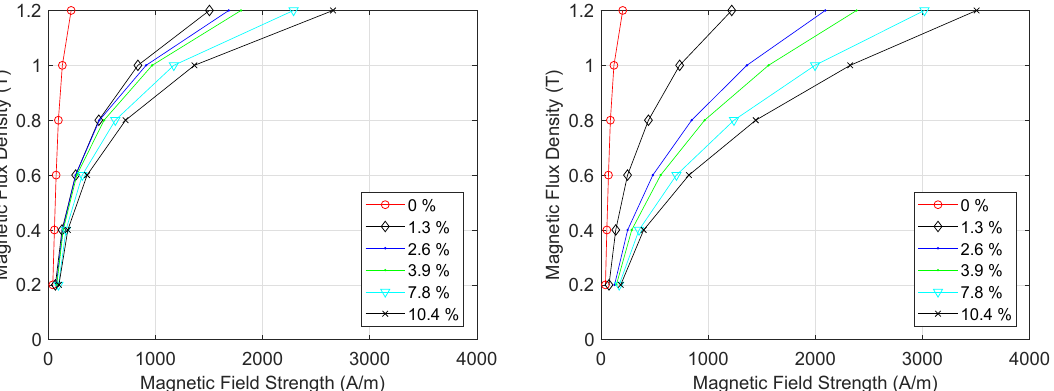
Figure 7. BH curves obtained at several levels of pre-release strain from the DD-samples both before ( left ) and after ( right ) the load was released.